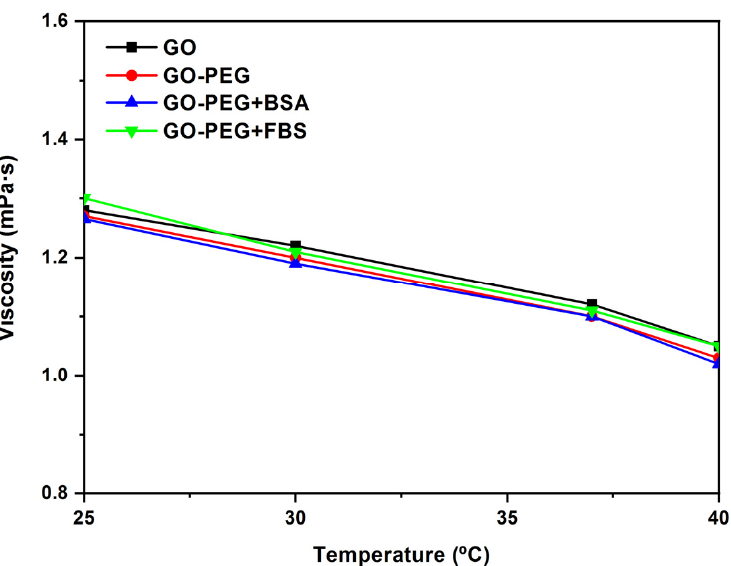
Figure 10. Viscosity ( η ) vs. temperature (°C) of GO, GO-PEG, GO-PEG + BSA, and GO-PEG + FBS dispersions at a concentration of 0.125 mg/mL and shear rate = 500 s − 1 .